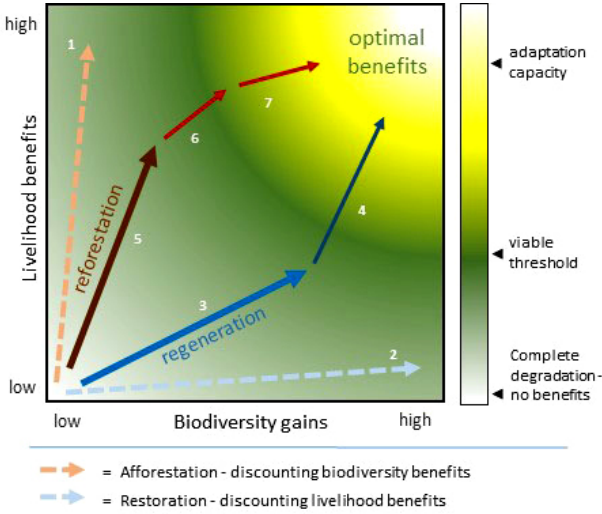
Fig. 3 . The trade-offs that people may need to make between biodiversity maintenance and livelihood benefits.